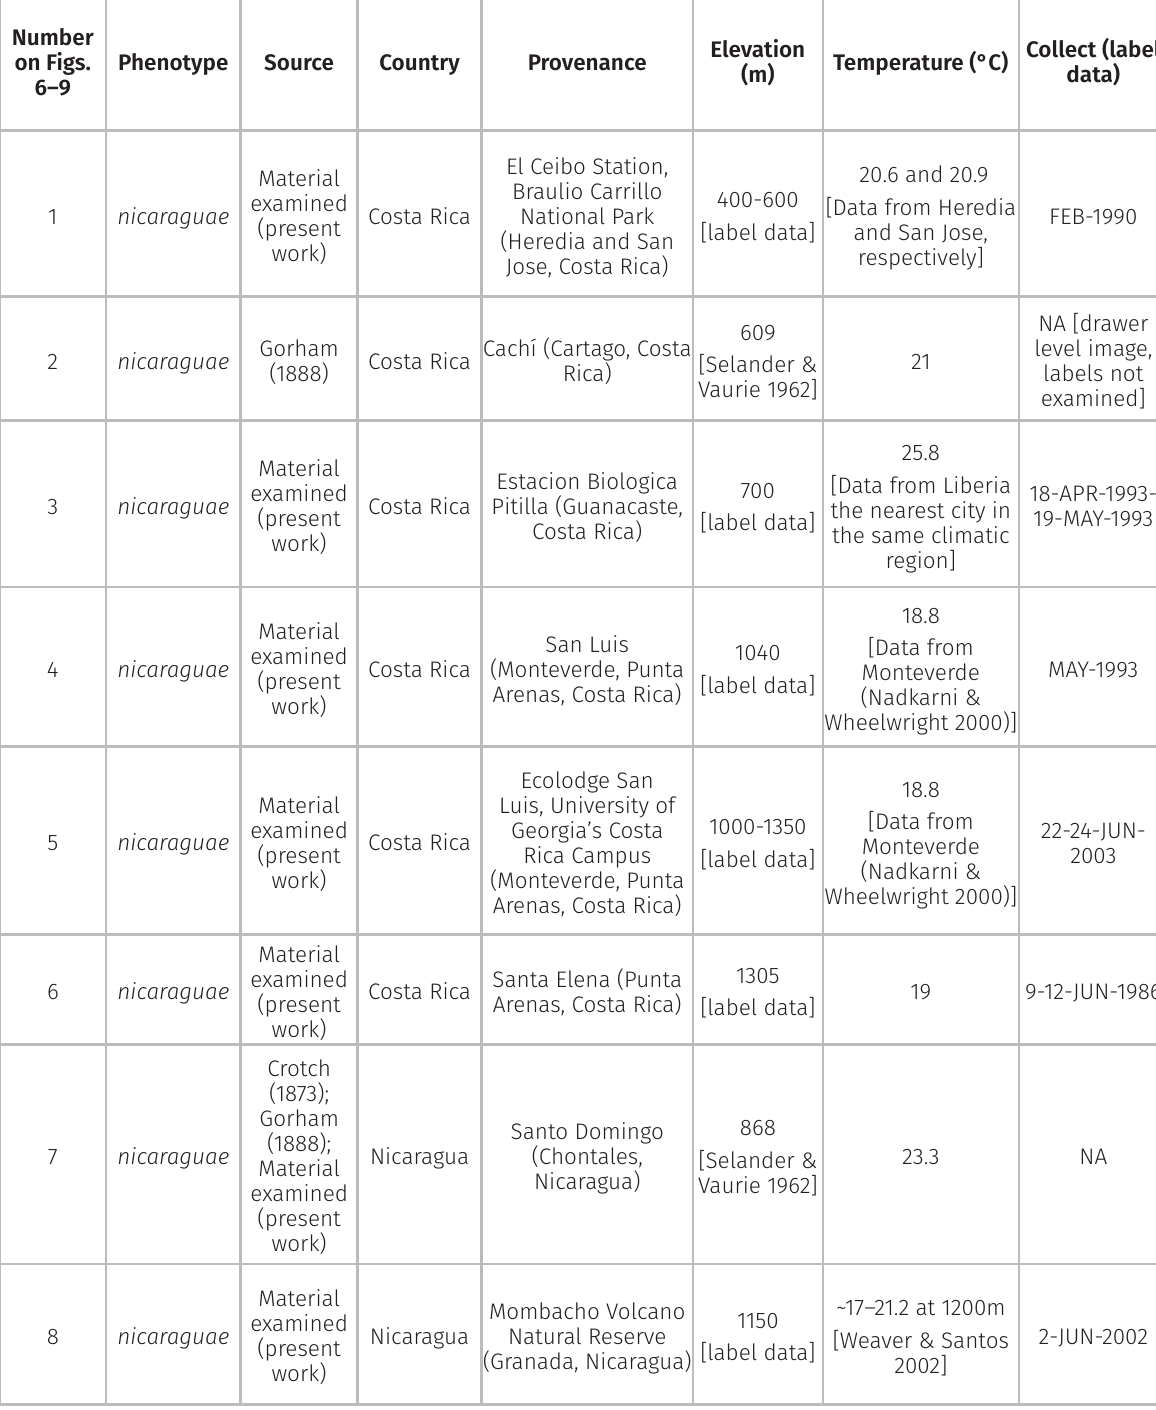
Table I. Elevation (m) and annual mean temperature (°C) from localities where the two morphs of Erotylina leoparda (Lacordaire, 1842) (“ leoparda ” and “ nicaraguae ”) were collected. Specific information, sources, etc., are in square brackets. Data are organized by country and under a gradient of elevation.